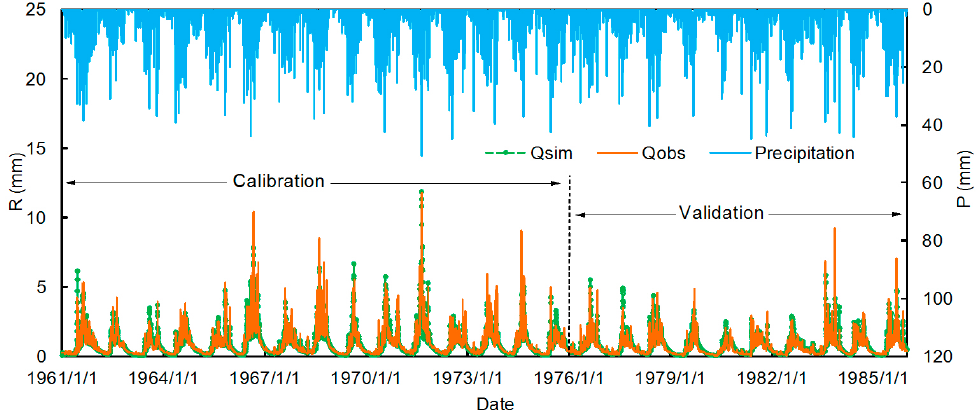
Figure 5. Comparison of the observed and simulated daily runoffs during the calibration and validation periods for the URRB.